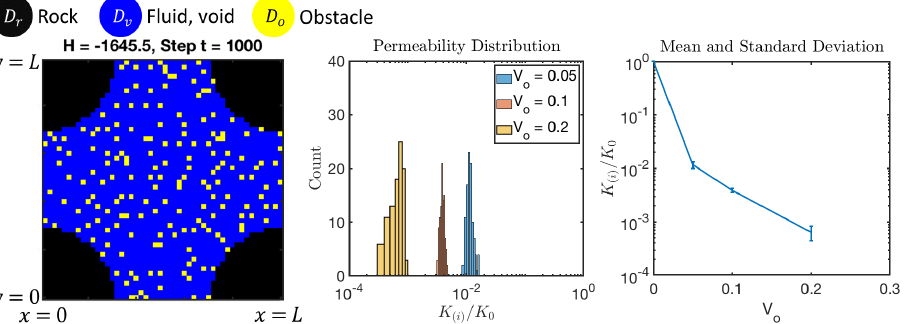
Figure 23. Results of LP model for disaggregated obstructions from Section 6.1.3. Left: one of the realizations for V o = 0.1. Middle and right: relative change in permeability due to colloidal obstructions. Note the log scale used for K ( i ) / K 0